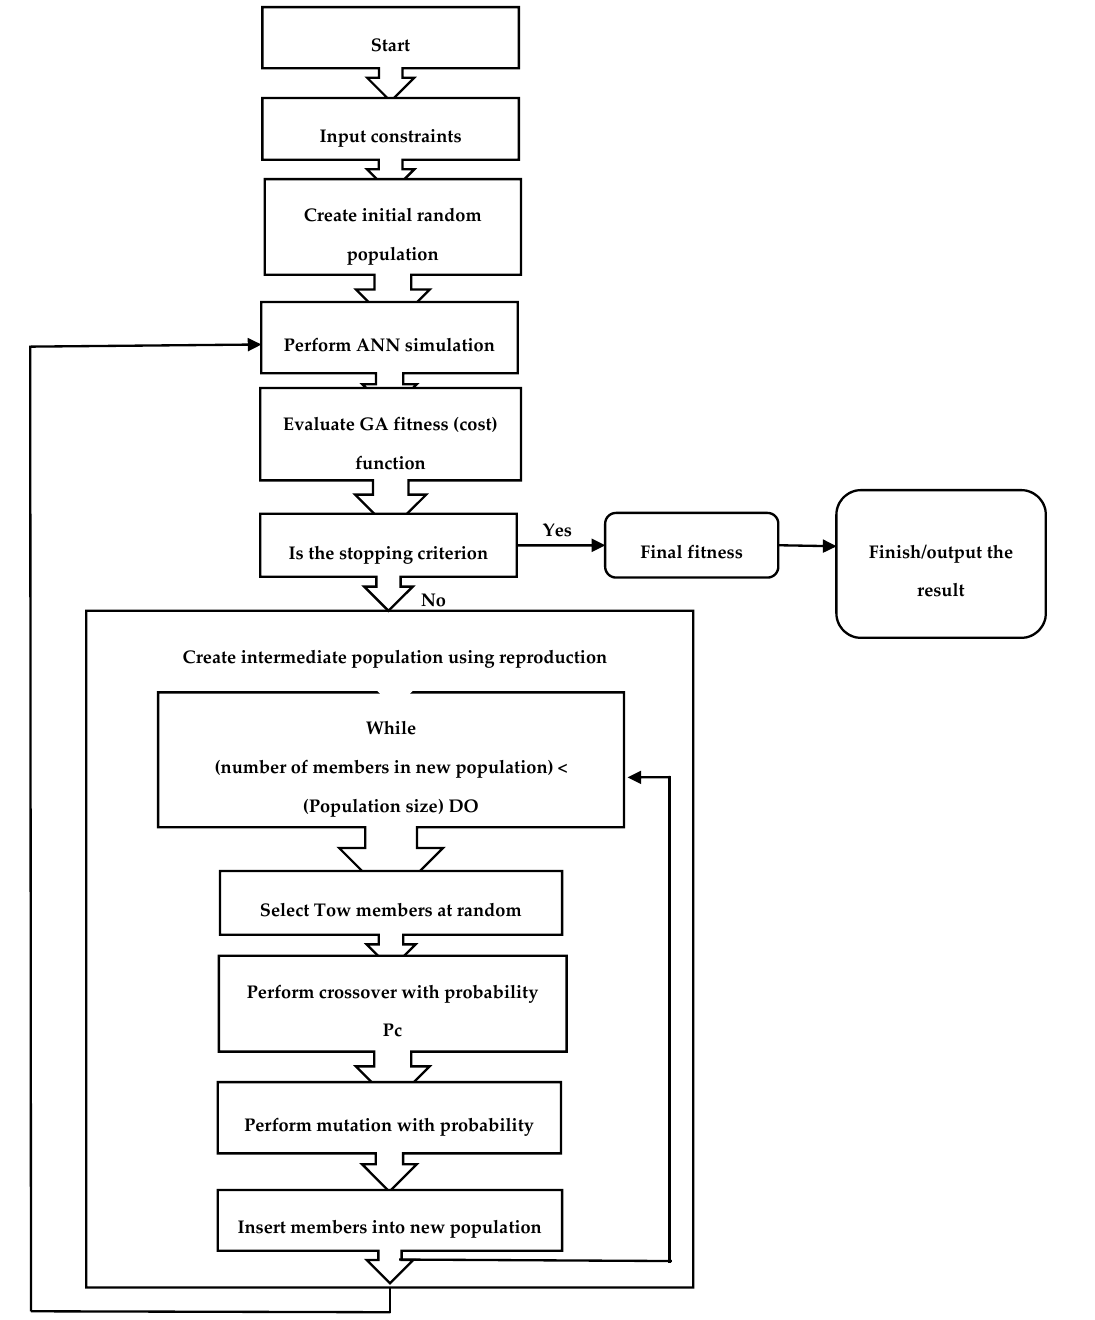
Figure 2. Schematic relationship of artificial neural network (ANN) model (GRNN) and optimization genetic algorithm (GA).